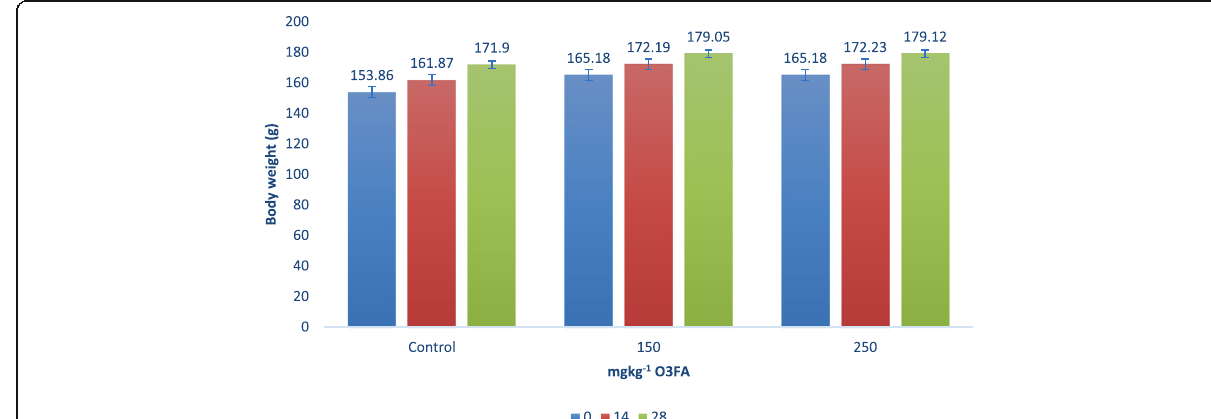
Fig. 2 Effect of O3FAs on body weight (g) in female